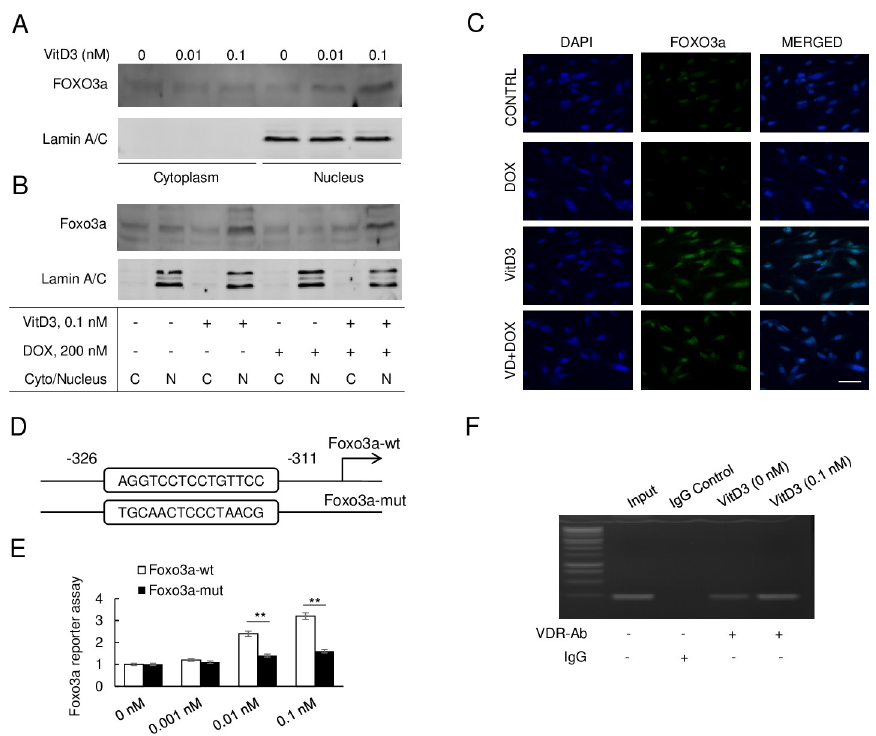
Fig 6. VitD3 modulates FOXO3a activity through both transcription and nuclear translocation. (A) Immunoblot of FOXO3a in cytoplasm and nucleus of VitD3 treated HAECs, Lamin A/C as nucleus control. (B) Immunoblot of FOXO3a in cytoplasm or nucleus of HAECs under VitD3 and/or DOX treatment. (C) Immunofluorescence staining of FOXO3a under VitD3 and DOX treatment. DAPI as nucleus control. Scar bar, 10 μ m. (D) Genomic analysis of the promoter region and a traditional VDR binding domain was acquired on -326 to -311 ( AGGTCCTCCTGTTCC ). Gene modification mutated this fragment and named as Foxo3a-mut. (E) Luciferase reporter assay performed with Foxo3a- wt, or Foxo3a-mut under VitD3 treatment. (F) CHIP assay performed with the VDR antibody under VitD3 treatment of